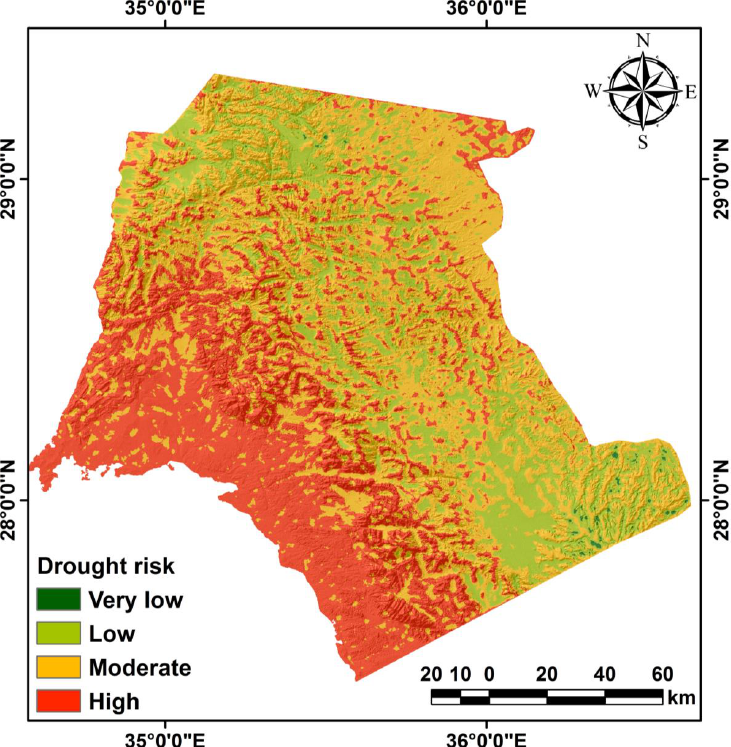
Figure 12. Map showing the possibilities of drought in each area in Neom. Approximately 7978 km 2 of the area exhibits a high drought risk. Table 3. Showing the layers used to predict the potential drought zones in Neom and the priority and rating of each layer. Layer Influence (%) Parameter Scale